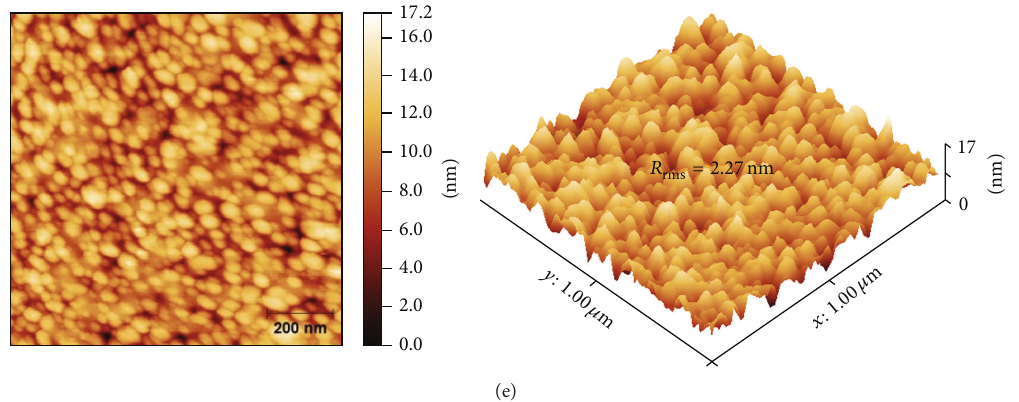
Figure 5: 2D and 3D AFM images of Ag doped ZnO thin films: (a) 0.0 at.% Ag, (b) 0.3 at.% Ag, (c) 0.5 at.% Ag, (d) 0.7 at.% Ag, and (e) 0.9 at.% Ag.